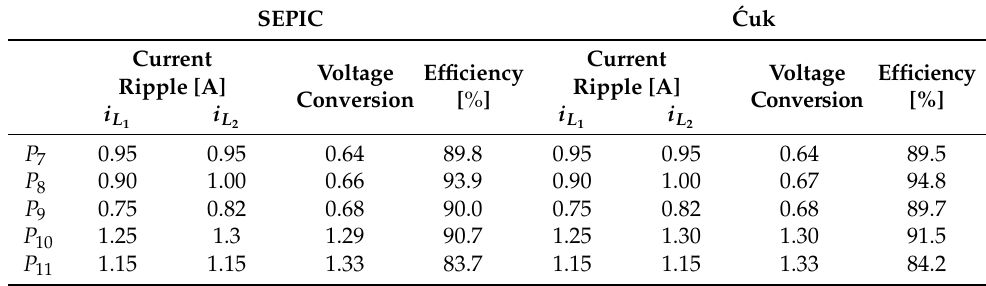
Figure 17. Inductor current waveforms in a closed-loop control with a voltage conversion ratio of 1.4: ( a ) SEPIC in point P 10 , ( b ) ´Cuk in point P 10 , ( c ) SEPIC in point P 11 , and ( d ) ´Cuk in point P 11 , (400 mA/div, DC coupling, and a time base of 1.4 µ s). Table 4. Analysis of the experimental